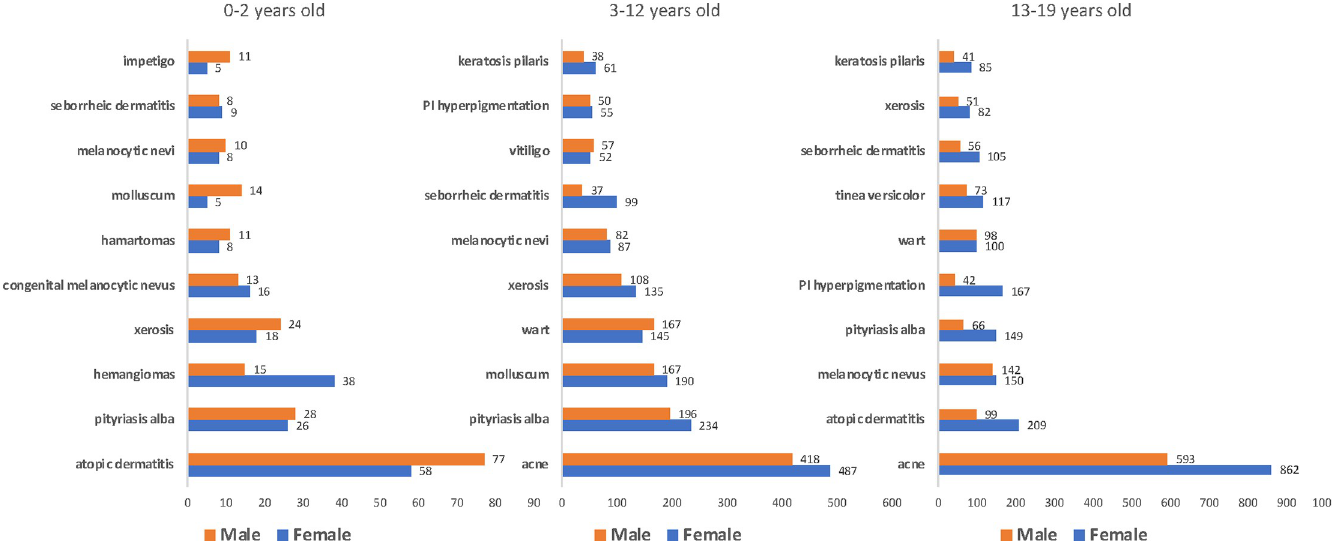
Fig 2. Most frequent diseases in patients 0–19 years old who participated in the Teledermatology Project according to age and sex, from July 2017-July 2018, in the city of S ã o